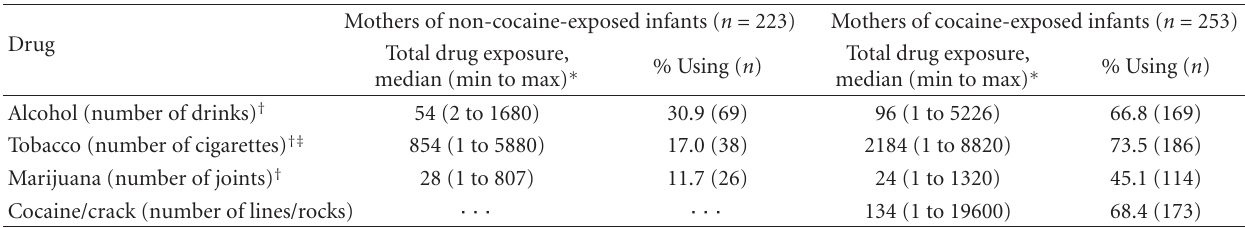
Table 2: Self-reported drug use during pregnancy among women giving birth to infants with or without prenatal cocaine exposure in the Miami Prenatal Cocaine